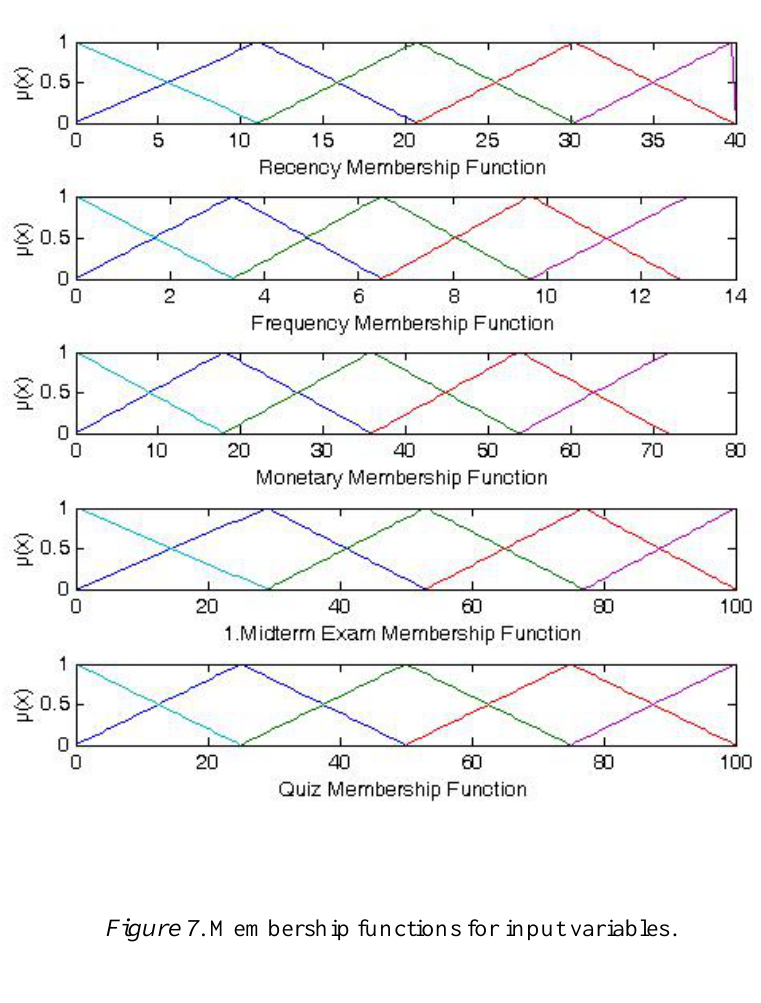
Figure 7 . Membership functions for input variables.